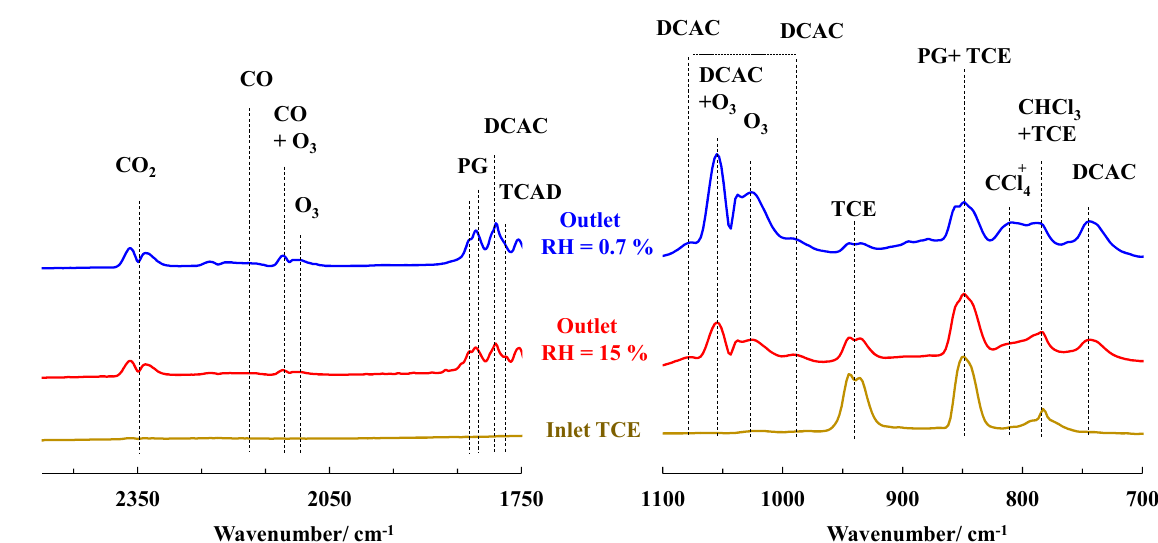
Figure 7. FT-IR spectra for the ranges 2500–1700 cm − 1 and 1110–700 cm − 1 of the outlet stream after NTP with 0.7% 15% as relative humidity (ED = 150 J/L, Q= 1 L/min). PG: phosgene; DCAC: dichloroacetylchloride; TCAD: trichloroacetaldehyde.